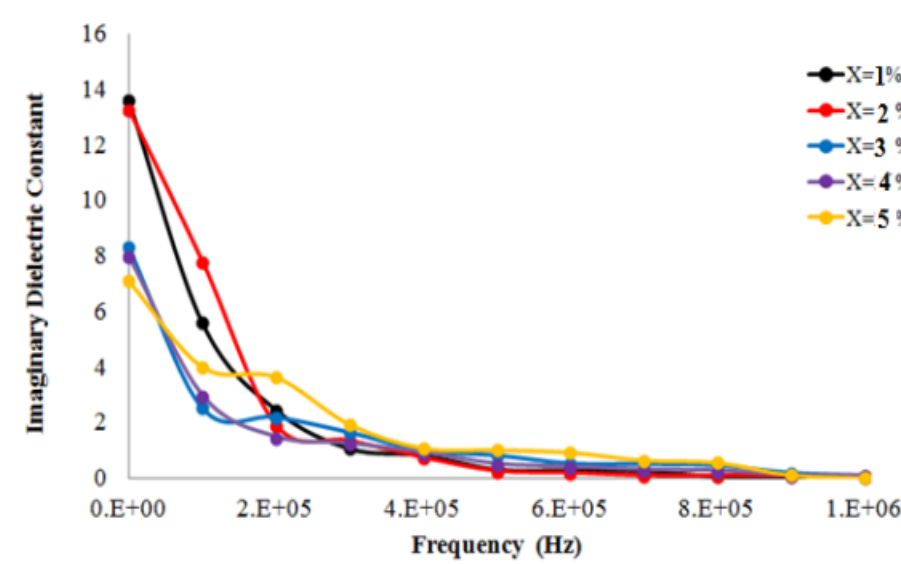
Fig.9: The (Kˋ) values for UP/nano SiO